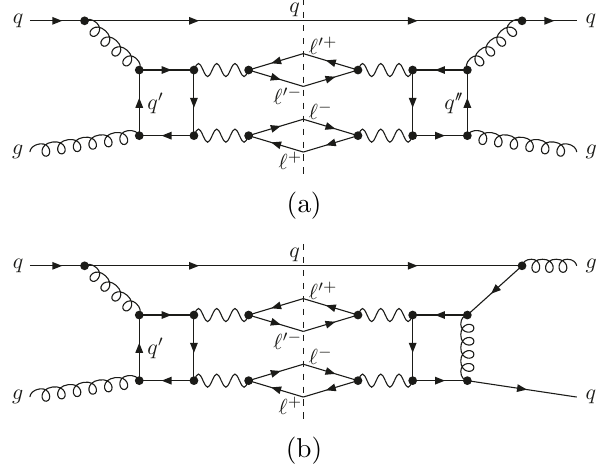
Figure 2 . Example of NNLO interference between quark annihilation and loop-induced gluon fusion production mechanisms.